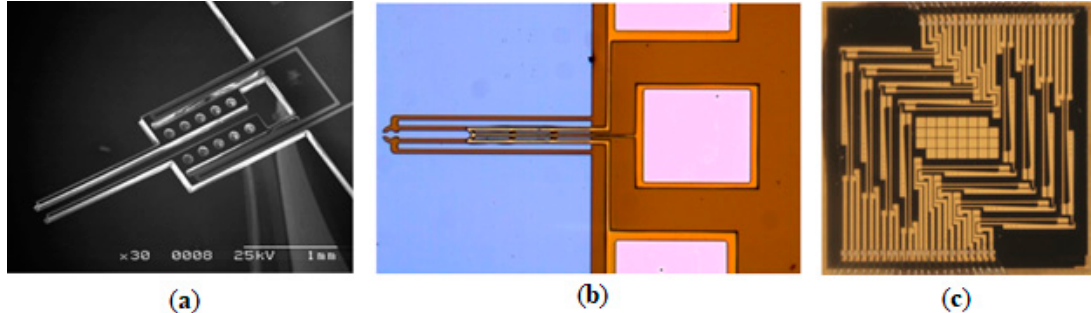
Figure 2. Applications of hot-and-cold-arm actuators: ( a ) microgripper [35]; ( b ) microgripper [36]; ( c ) switch matrix for wireless communications [37].